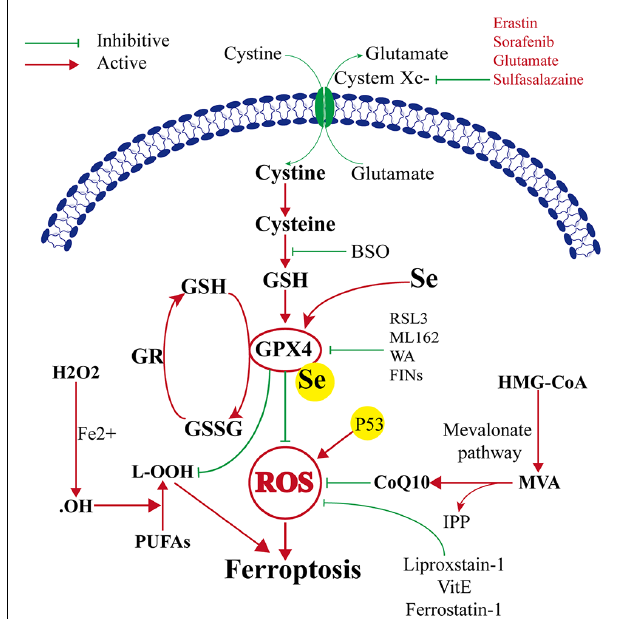
FIGURE 1 | Mechanism of ferroptosis, glutathione peroxidase 4 (GPX4) glutathione (GSH) cysteine axis and mevalonate